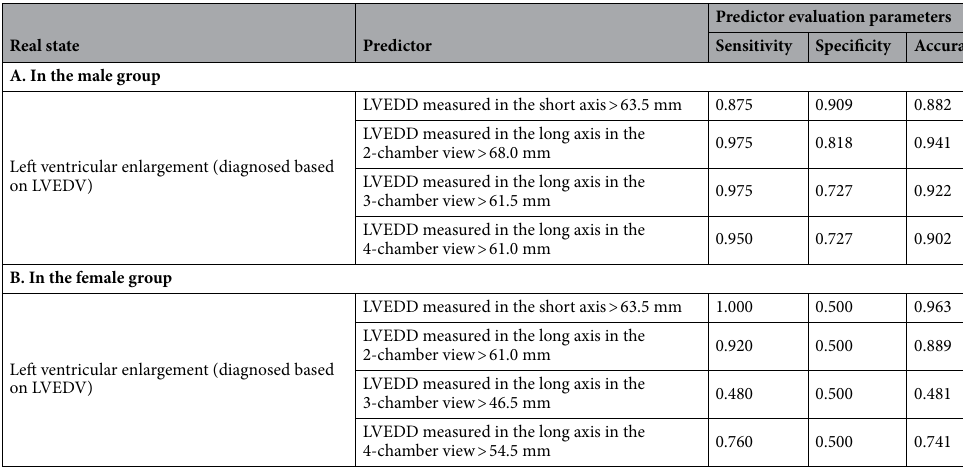
Table 6. Prediction of left ventricular enlargement (diagnosed based on left ventricular end-diastolic volume) based on left ventricular end-diastolic diameter measured in CMR.